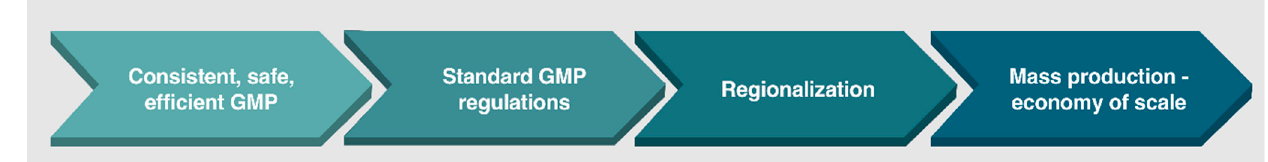
Figure 5. Steps to achieve widespread use of inducible pluripotent stem cell-based islet cell transplant.